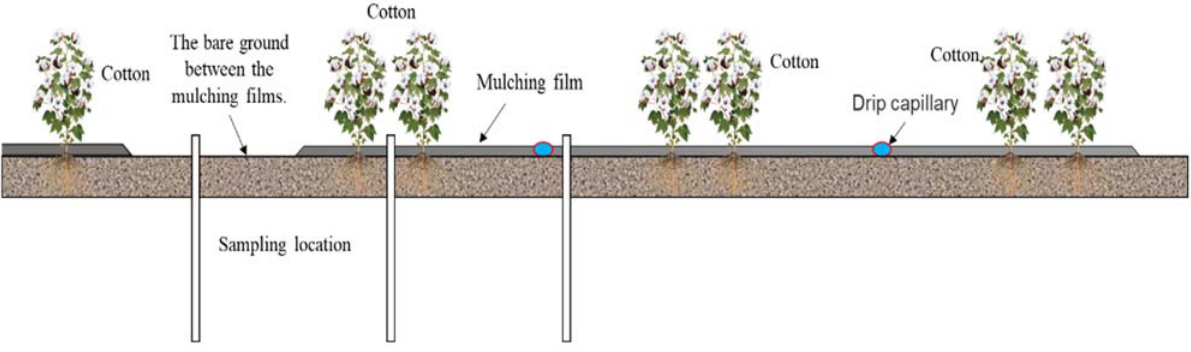
Figure 3. The planting mode of one film, two tubes, and six rows.